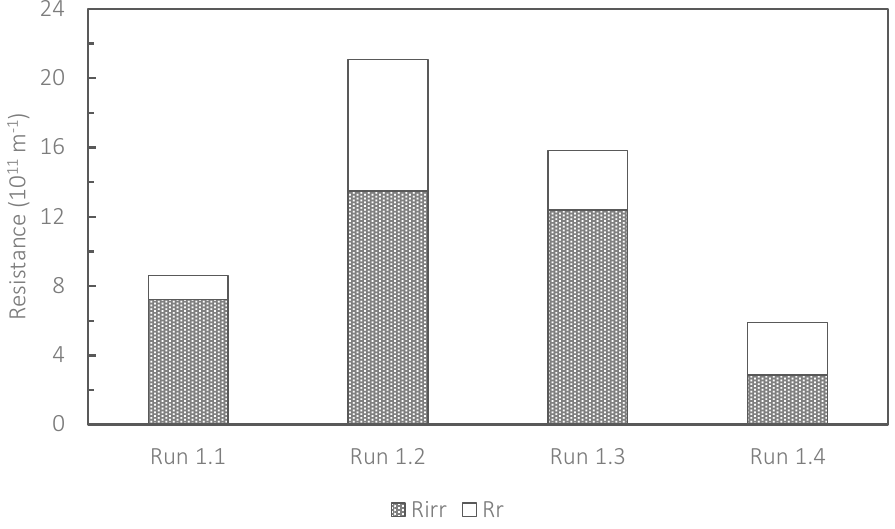
Figure 3. Distribution of fouling resistances assessed at the termination of Runs 1.1, 1.2, 1.3 and 1.4.